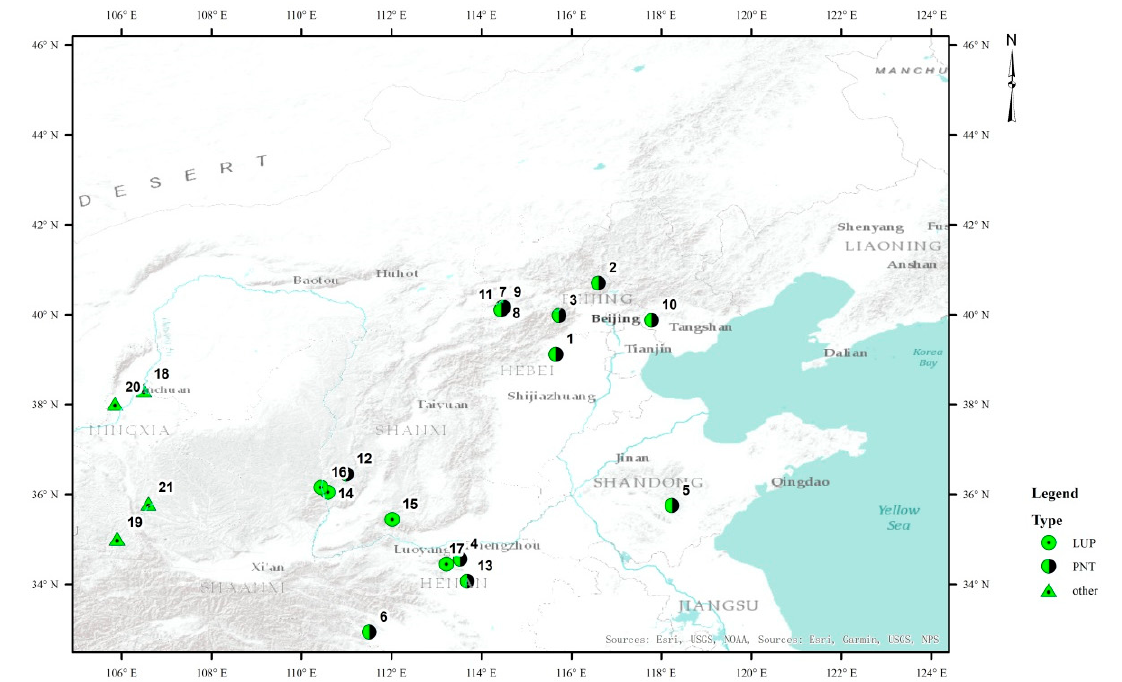
Figure 1. Archaeological sites dated to Pleistocene-Holocene transition in Northern China. PNT sites: